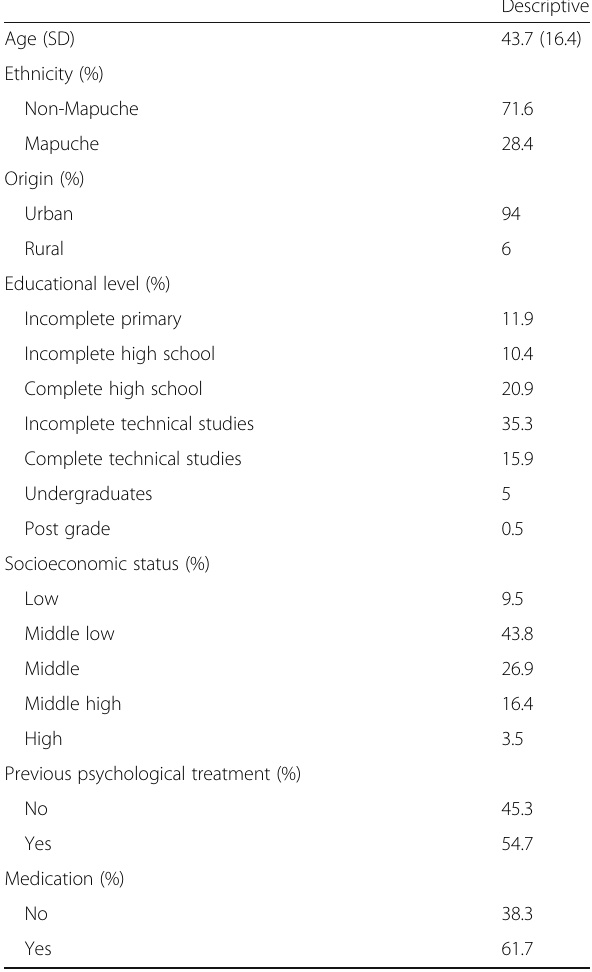
Table 2 Composition of the sample — phase III